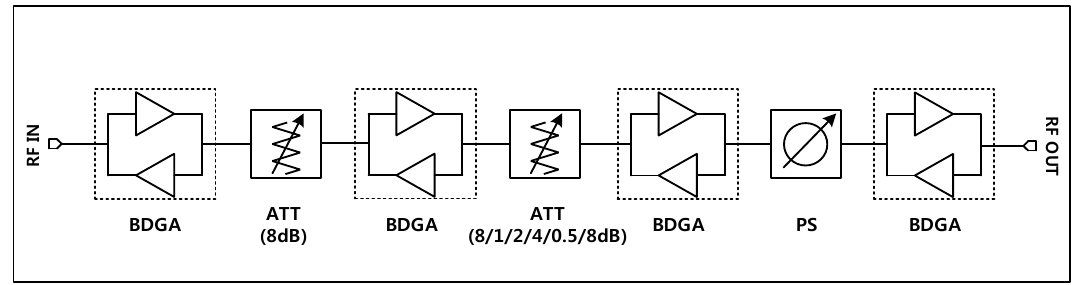
Figure 1. A block diagram of the proposed X-band TRM.